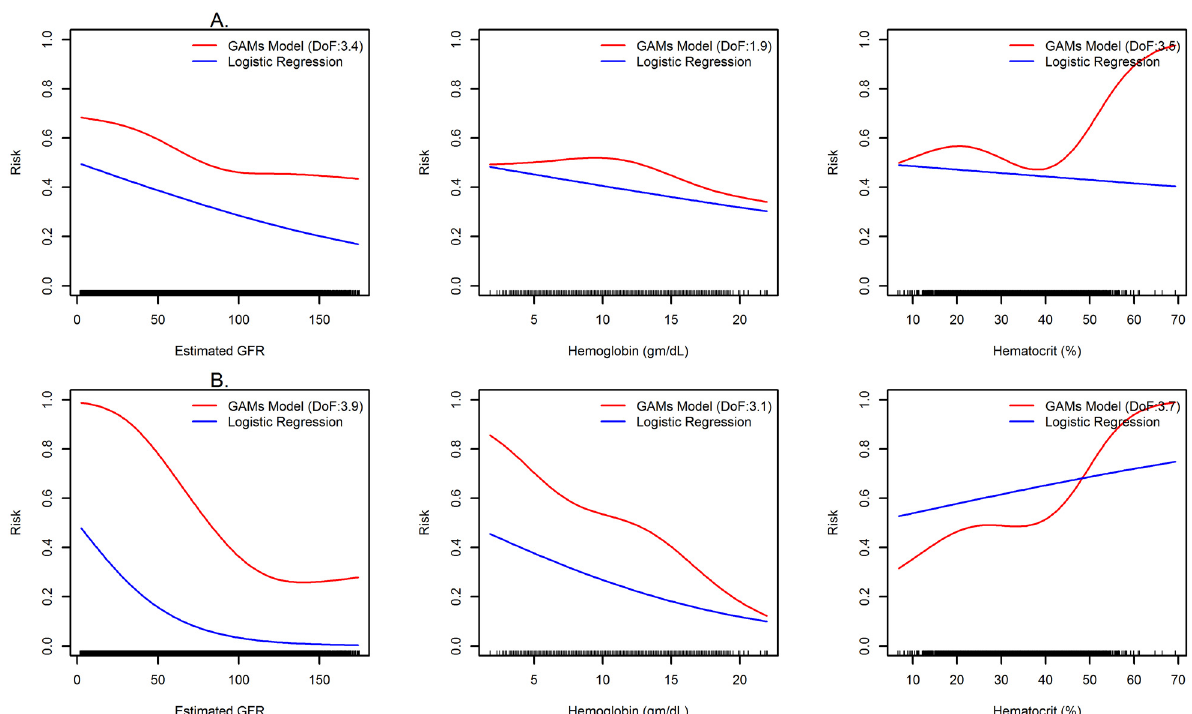
Fig 2. Predicted risk functions for the association between (A) acute kidney injury and (B) severe sepsis and continuous variables. Risk functions were generated from multivariate generalized additive models and logistic regression models. GAM, generalized additive model; DoF, degree of freedom; GFR, glomerular filtration